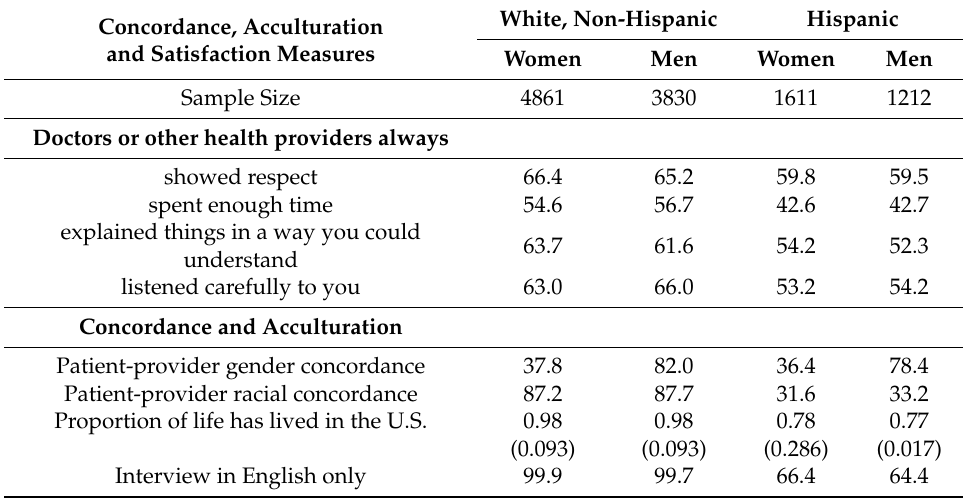
Table 2. Provider Concordance, Acculturation and Satisfaction Measures by Race and Gender. Concordance,